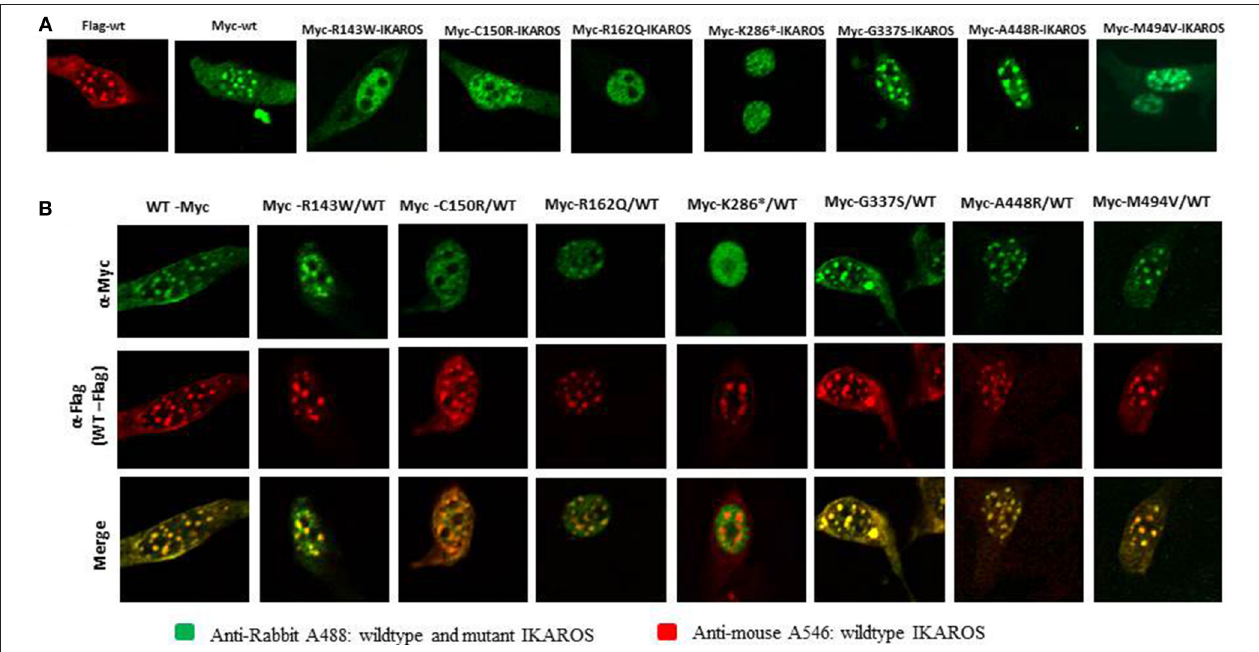
FIGURE 4 | The results of confocal microscopy with epitope-tagged constructs were consistent with the results of Immunofluorescent microscopy. (A) NIH3T3 cells, transiently overexpressing epitope-myc/FLAG-tagged wildtype IKAROS and myc-tagged mutant forms were incubated with monoclonal rabbit anti myc-tag-antibody and mouse monoclonal anti-FLAG M2 antibody and stained with goat anti-rabbit Alexa fluor 488 (green) and goat anti-mouse Alexa 546 (red). In NIH3T3 cells transfected with epitope-myc/FLAG-tagged wildtype IKAROS the speckled nuclear localization was observed in contrast to a diffuse nuclear staining, observed in NIH3T3 cells expressing the myc-tagged Arg143Trp, Cys150Arg, Arg162Gln, and Lys286* mutant forms. (B) Wildtype components were dominant to form IKAROS complexes in PC-HC sites. NIH3T3 cells were co-transfected with 50% of myc/FLAG-tagged wildtype IKAROS and 50% of myc-tagged, expressing each mutant form. The diffuse nuclear localization of the mutant forms was significantly reduced in NIH3T3 cells co-transfected with equal amounts of the FLAG-tagged wildtype IKAROS together with the myc-tagged Arg143Trp, Cys150Arg, and Arg162Gln. Accumulation of FLAG-tagged wildtype proteins, observed as a punctuated nuclear staining pattern in the co-transfected samples, showed the dominance of wildtype components to form IKAROS complexes in PC-HC